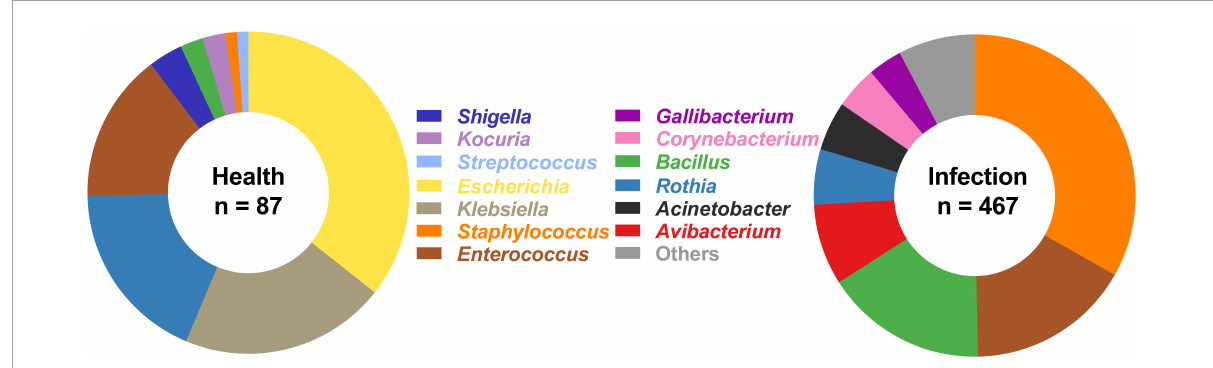
FIGURE1 Bacterial composition in upper respiratory tract from healthy chickens and IC chickens. In infection group, the bacterial genera with relative abundance of less than 2% were categorized into “Others” group, including Aerococcus spp. (0.21%), Carnobacterium spp. (0.21%), Enterobacter spp. (0.64%), Escherichia spp. (0.21%), Lysinibacillus spp. (1.71%), Paenibacillus spp. (0.21%), Streptococcus spp. (1.07%), Stenotrophomonas spp. (0.43%), Vibrio spp. (0.21%), and Kocuria spp. (1.71%).